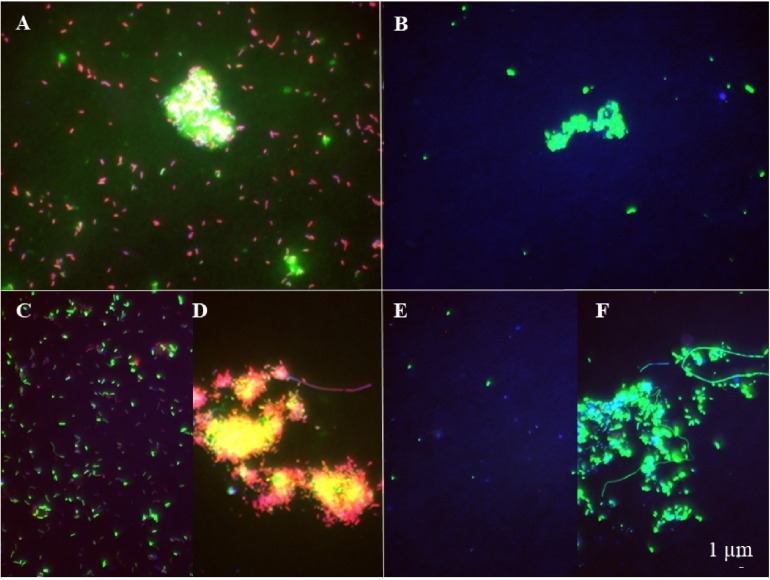
Epifluorescence microscopy images of respiring (A, B) and bacterial populations taking up HPG (C–F) at the late exponential phase (A, C, D) and the senescent phase (B, E, F) in the jelly-OM treatment. Red colored cells – bacteria hybridized with FISH probe and stained with DAPI, green colored cells – bacteria hybridized with FISH probe, stained with DAPI and incorporating HPG (C–F) and Redox Sensor Green (A, B).